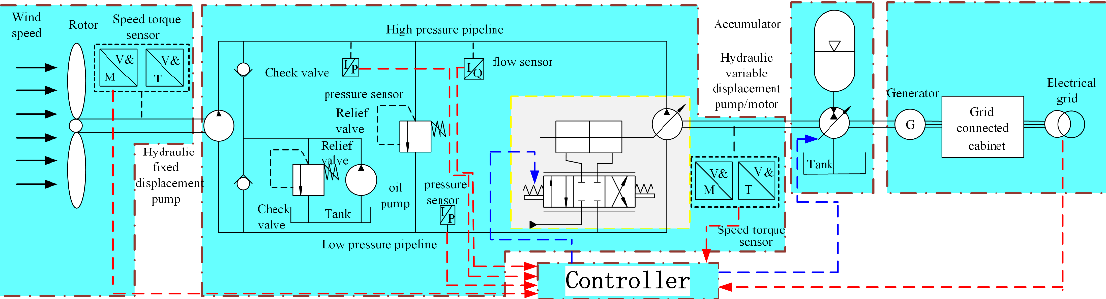
Figure 20. HWT semi-physical simulation experiment platform schematic diagram.